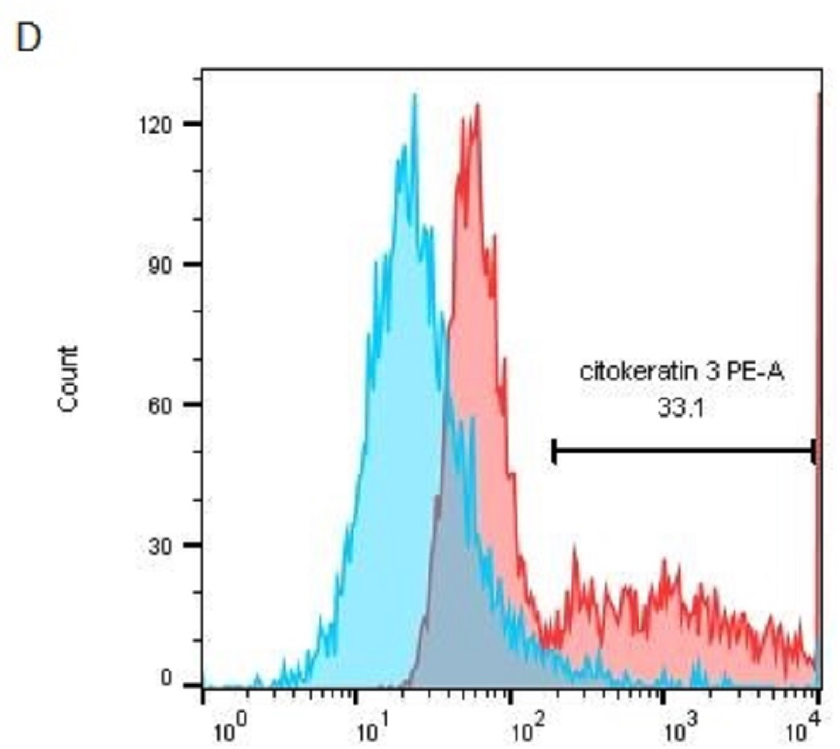
Figure 12. Flow cytometric representative analysis of p63 and cytokeratin 3 expressions in LSC cells stripped from the unmodified PLA scaffold (sample 1); ( A ) 87.7% of acquired events in the gate 1 are singlets based on FSC-A vs. FSC-H signal distribution; ( B ) singlets from the gate 1 were analyzed using FSC-A, and SSC-A signals and individual cells are gated as gate 2 (92.9% of events in gate 1); ( C ) representative histogram of cells from the gate 2 was analyzed for PE fluorescence for isotype PE-conjugated antibody (red line) or specific anti-p63 PE-conjugated antibody (blue line); ( D ) representative histogram of cells from the gate 2 was analyzed for PE fluorescence for isotype PE-conjugated antibody (red line) or specific anti-CK3 PE-conjugated antibody (blue line); The limit of the negative/positive cells was set at 1% on samples labeled with isotype antibody for both histograms. Table 2. Percentages of p63 and CK3 expressions of LSCs grown on PLA and modified PLA